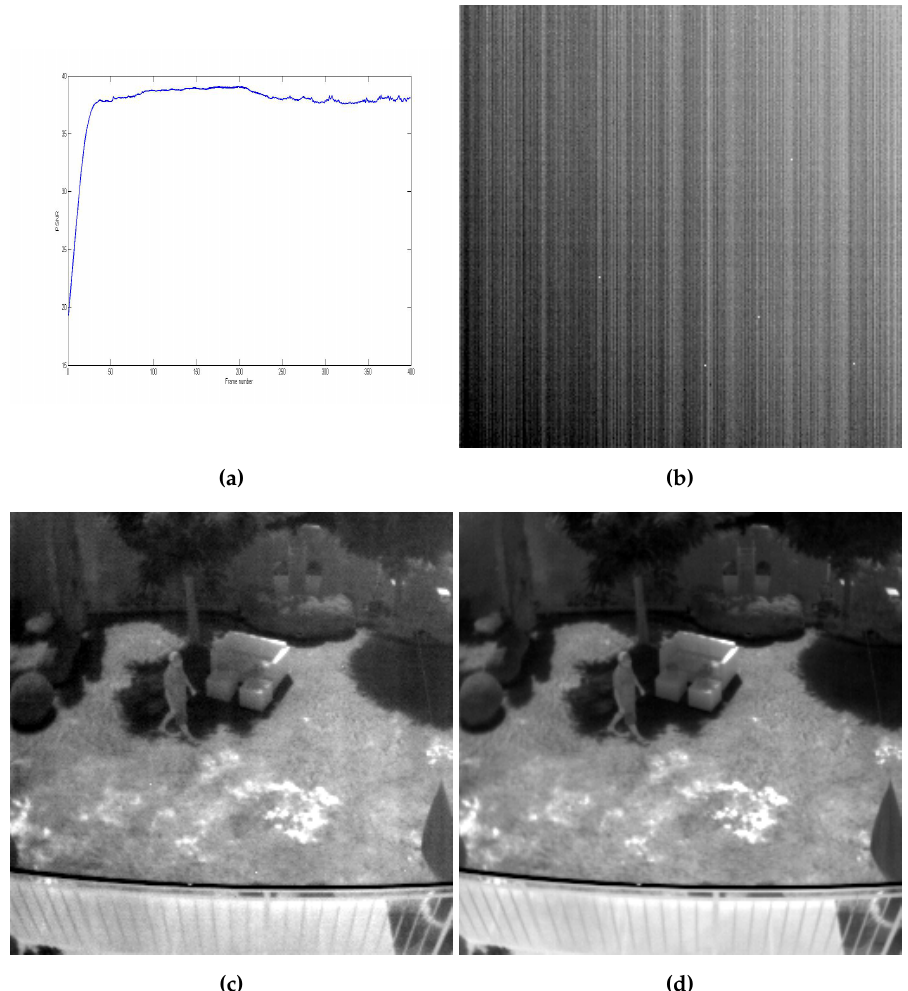
Figure 8. ( a ) PSNR as a function of the frame number of sequence 3; ( b ) real nonuniformity; ( c ) frame 300 corrected using the midway infrared equalization (MIRE) algorithm (PSNR = 32.91); and ( d ) frame 300 corrected using the proposed method (PSNR =